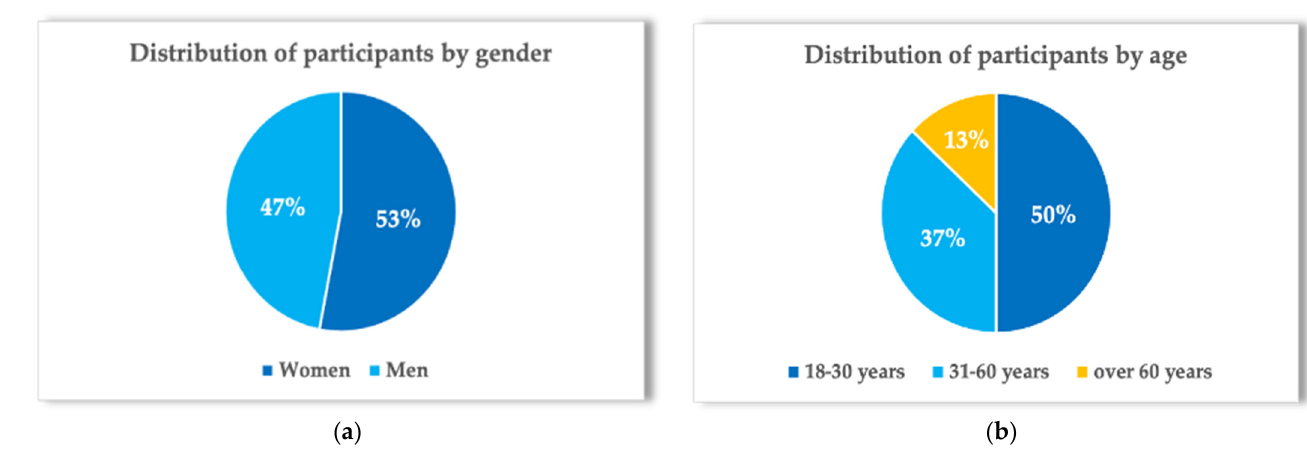
Figure 3. Division of the participants by gender ( a ) and age categories ( b ).